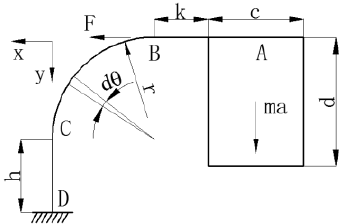
Figure 2. Simplified structure diagram of the sensor and the meaning of each symbol . x, y: the horizontal and vertical directions; F : force at point B; h : the height of CD segment; r : the radius of the bended segment; k : the length of horizontal segment; m : mass; c, d : the length and height of the mass; a : the exciting acceleration; dθ : the infinitesimal angle.